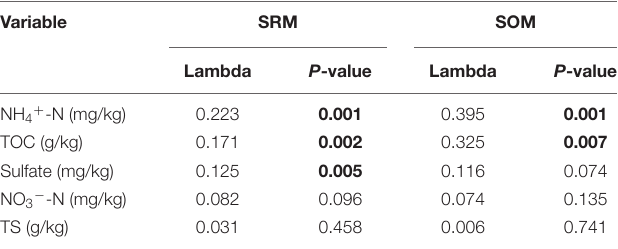
TABLE 2 | Significance of environmental variables with respect to the abundance of proteobacterial sulfate-reducing and sulfur-oxidizing microorganisms based on 16S rRNA sequences.